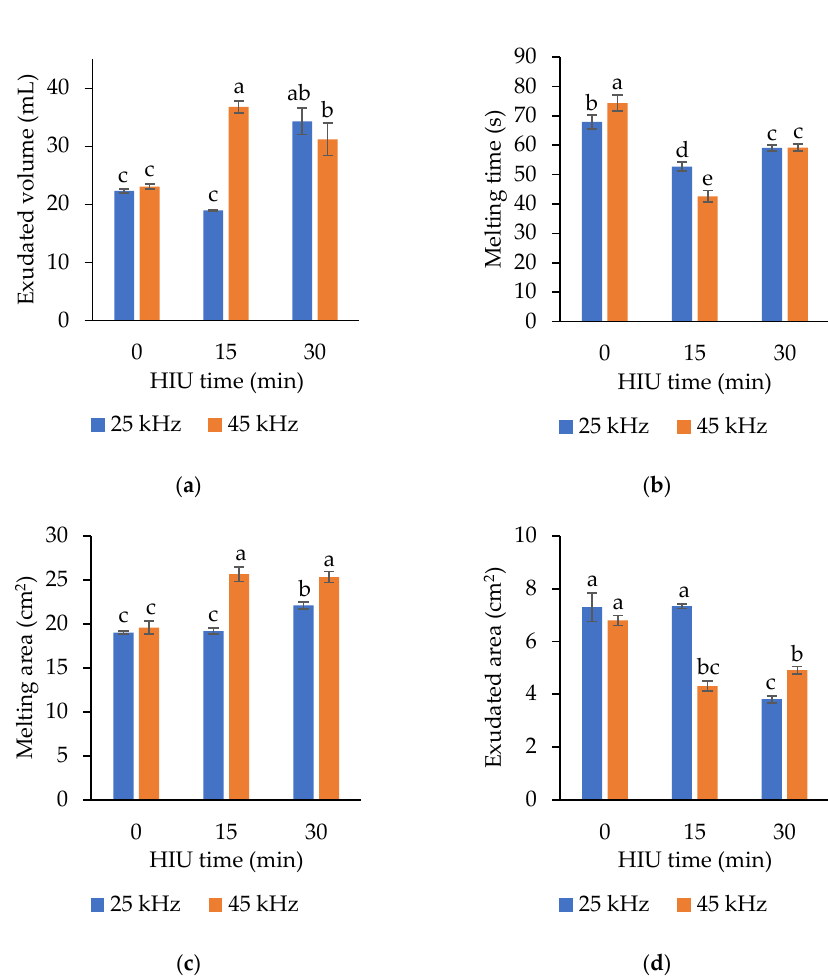
* Volume of exudated whey in the package of the cheese 24 h after processing. ** Melting capacity of the cheese due to the effect of temperature (125 °C) until the maximum expansion and the ap- pearance of exudate around the melted cheese. a,b,c Different letters within the same column indicate significant differences between treatments (Tukey’s multiple range tests, assuming a significant dif- ference at p < 0.05, n = 18).